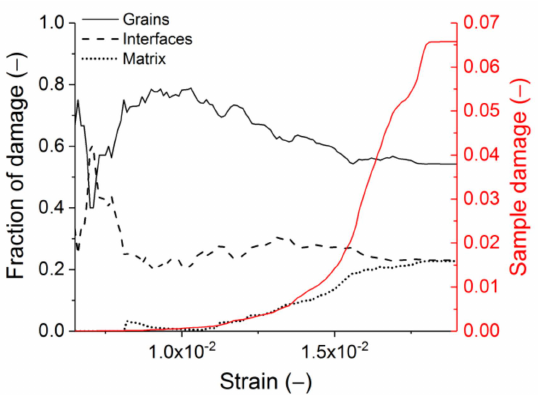
Figure 15. Contributions of constituents to the sample damage accumulation during dynamic compressive loading. The strain rate is 5 s − 1 . The red curve is the absolute sample